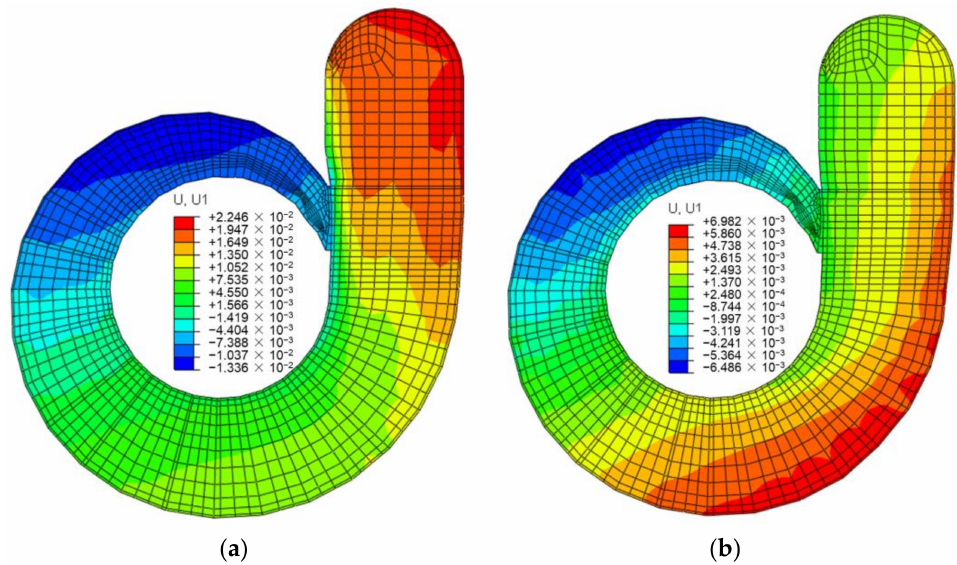
Figure 17. Displacement of the SSC in the longitudinal axis of the powerhouse (m): ( a ) non-circle case; ( b ) circle case.